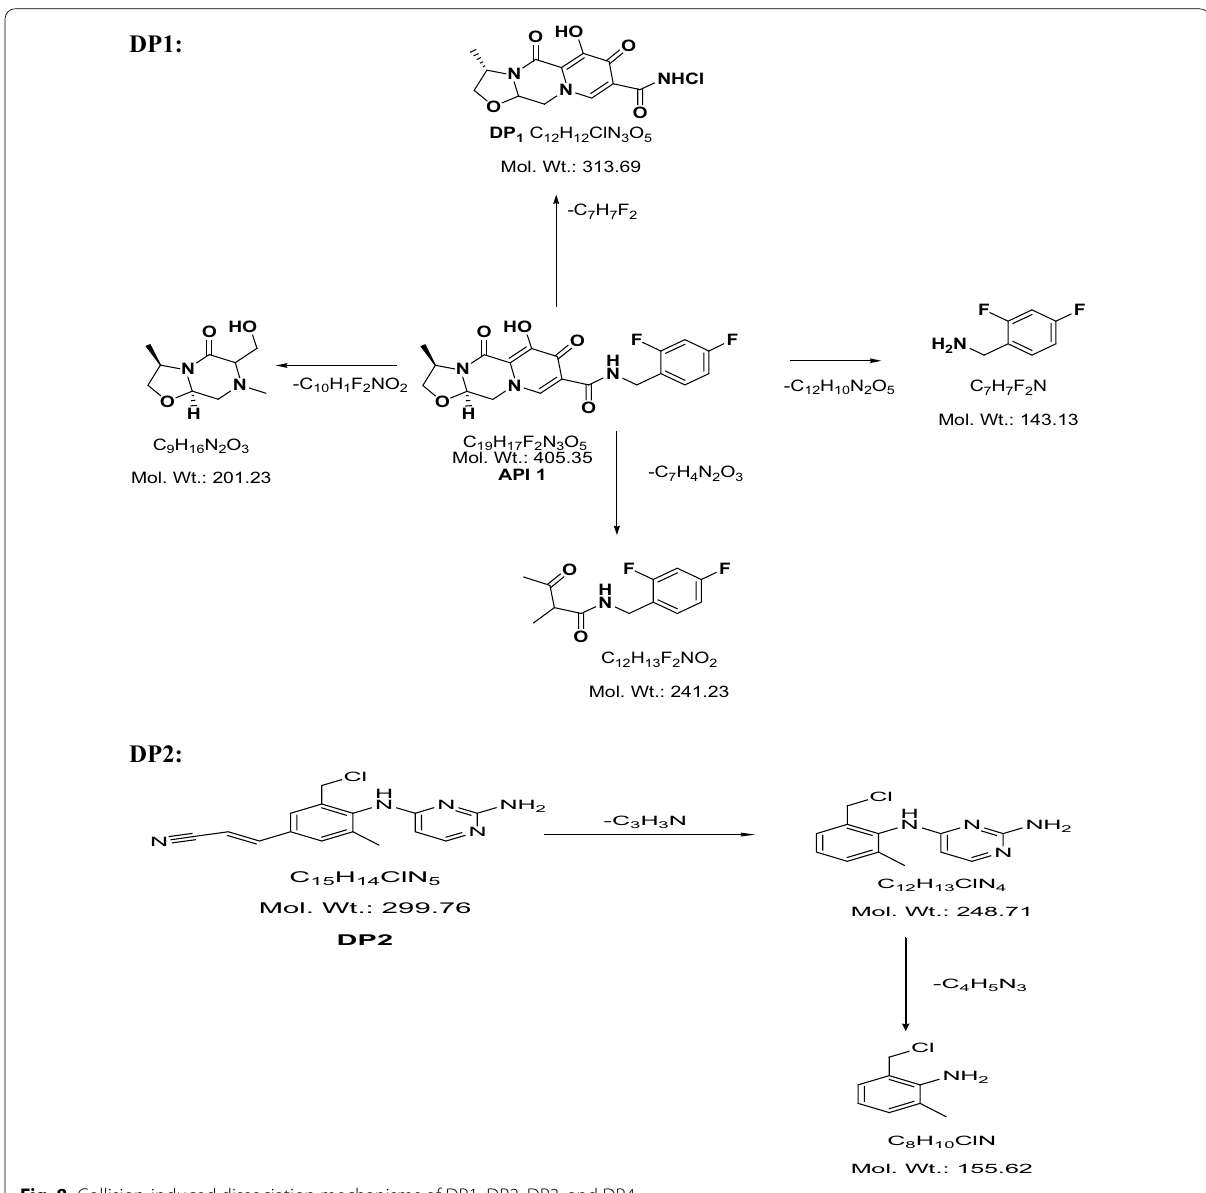
Fig. 8 Collision-induced dissociation mechanisms of DP1, DP2, DP3, and DP4